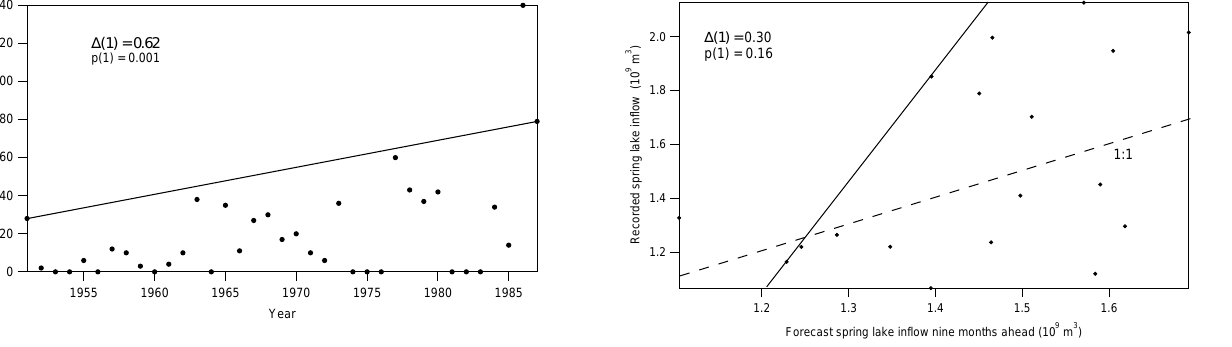
Fig. 3. Validation plot for a model forecasting combined spring river inflow volumes into Lakes Tekapo and Pukaki (New